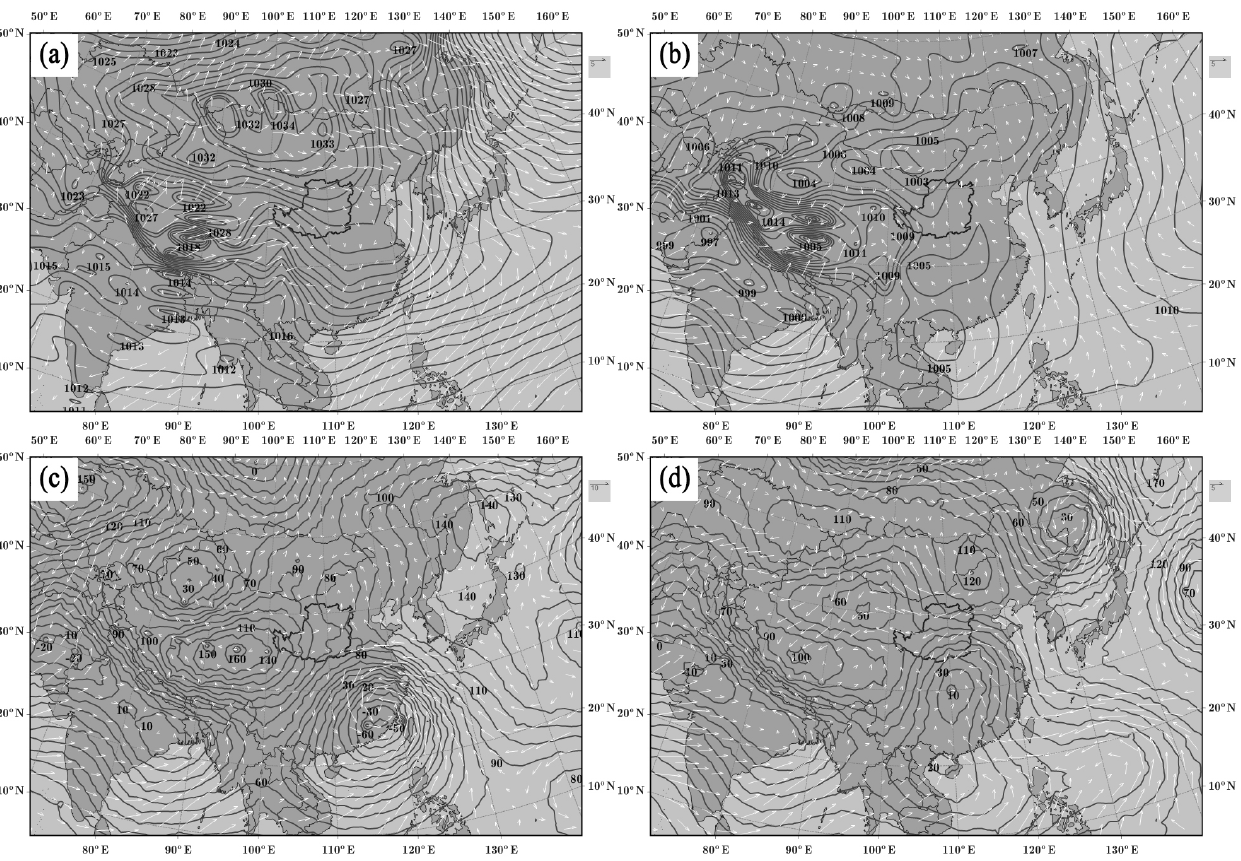
Figure 6. Average sea level pressure and winds: (a) the mean for all winters (from December to February) and (b) the mean for all summers (from June to August) from 1961 to 2015. Characteristics of the average 1000hPa geopotential height and winds on (c) 1 August 1996 and (d) 3 August 1996. The data were derived from global NCEP/NCAR reanalysis average monthly and daily